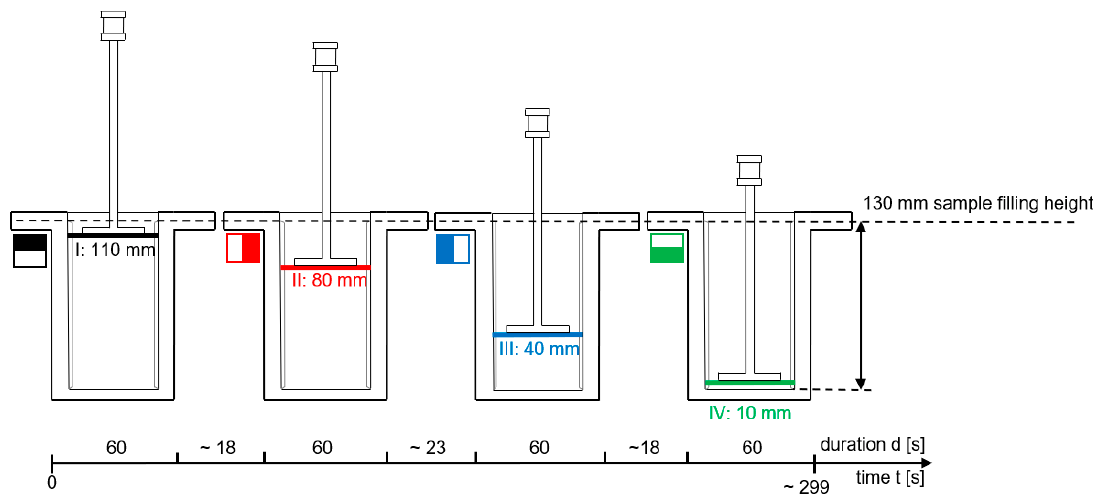
Figure 5. Illustration of the four measuring heights (I–IV) in a sample.